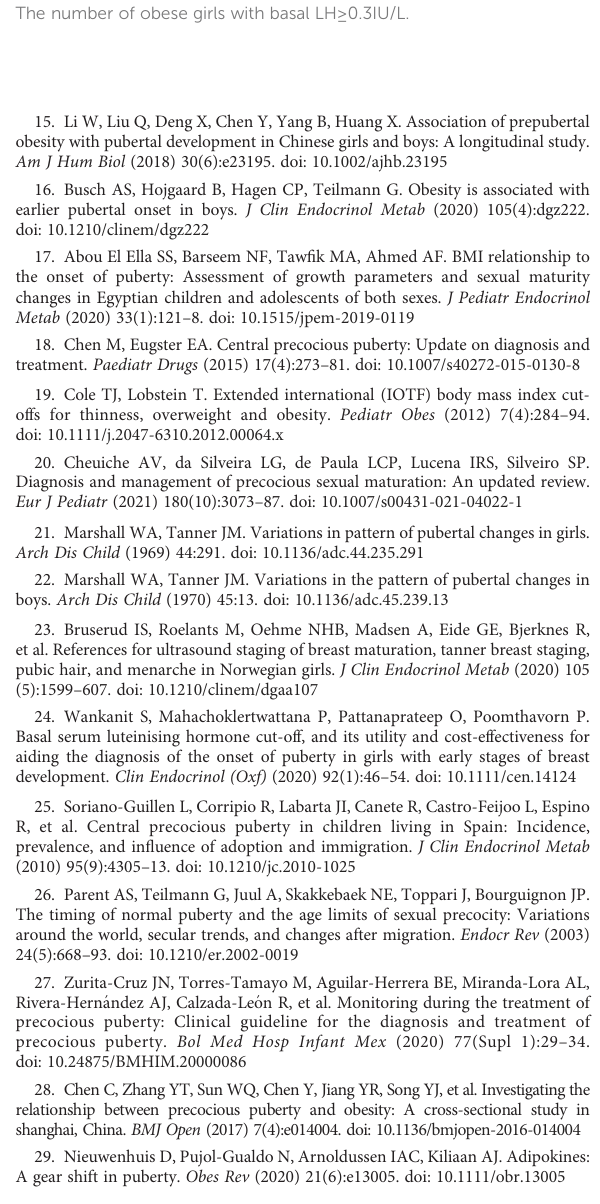
SUPPLEMENTARY TABLE 1 The number of children with basal LH ≥ 0.3IU/L.